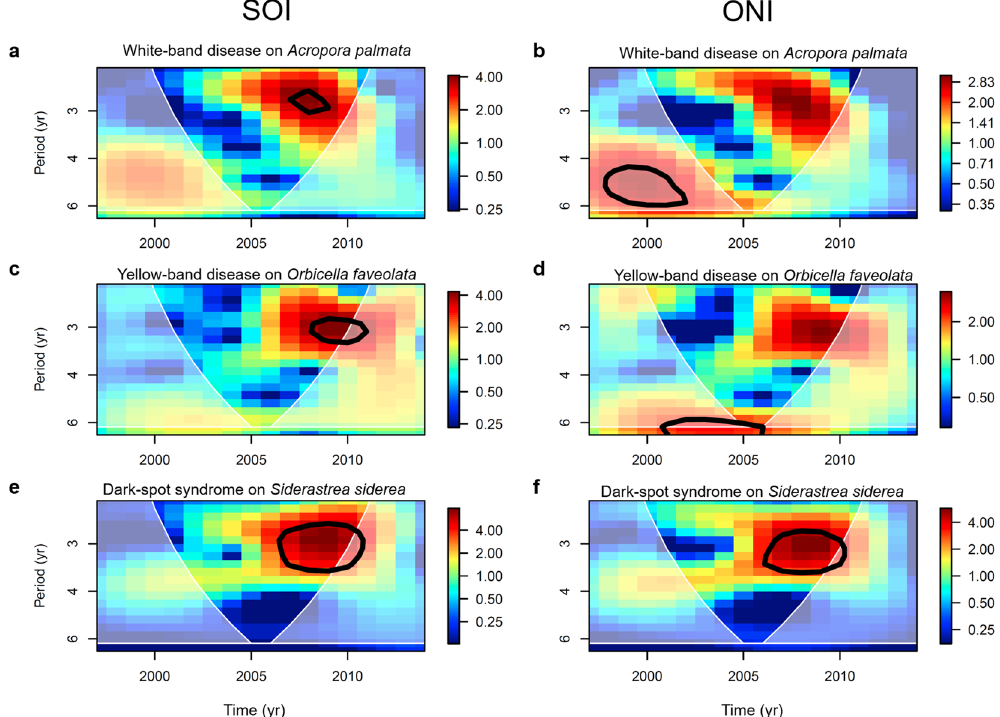
Figure 3. Cross-wavelet analyses comparing ENSO indices and disease records. Cross-wavelet analyses comparing yearly maximum prevalence of three coral diseases with two indices of El Niño Southern Oscillation (ENSO): The Southern Oscillation Index (SOI; left) and the Oceanic Niño Index (ONI; right). ENSO indices were compared with the prevalence of white-band disease on Acropora palmata ( a , b ), yellow-band disease on Orbicella faveolata ( c , d ), and dark-spot syndrome on Siderastrea siderea ( e , f ). Black contour lines indicate statistically significant periodicites at p < 0.05. The white lines outline the ‘cone of influence’. Colors indicate power spectra with warm colors denoting high